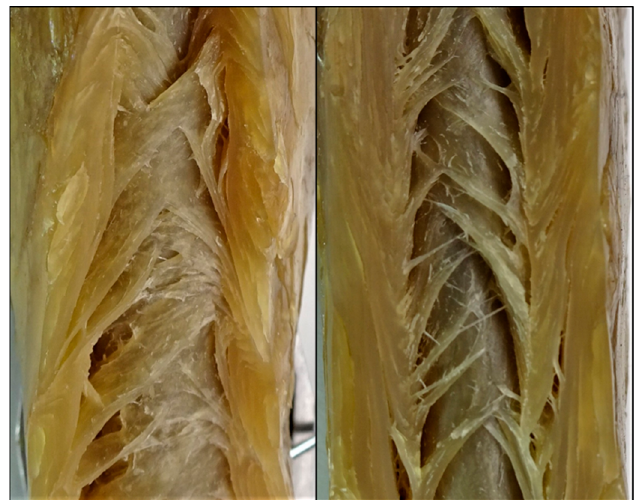
Figure 3. Product structure of extruded soy protein isolate (SPI) with material temperatures of 124 °C ( left ) and 135 °C ( right ) before cooling die. Water content (50%), screw speed (250 rpm) and mass flow (10 kg/h) were held constant. Increase in material temperature was induced by increasing the barrel temperature.